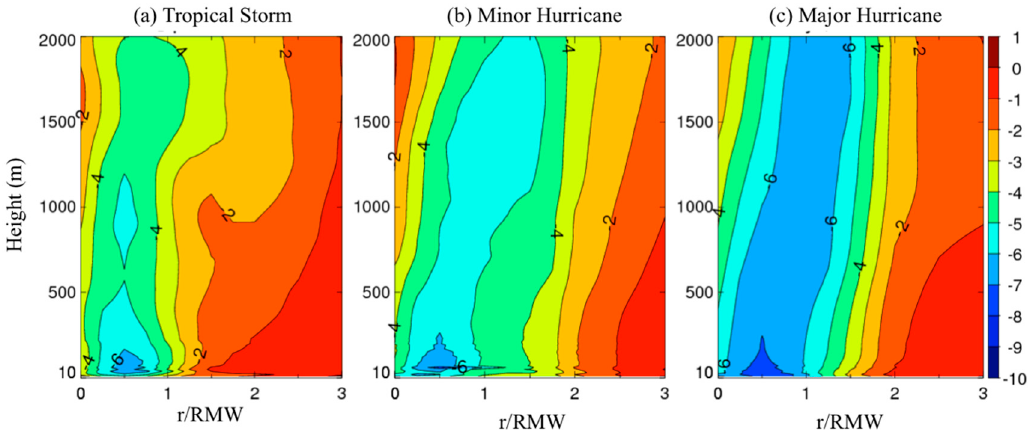
Figure 12. Composite analysis of the radial derivative of equivalent potential temperature as a function of altitude and normalized radius for ( a ) tropical storms, ( b ) minor hurricanes, and ( c ) major hurricanes. The contour interval is 1 K km − 1 in all panels.